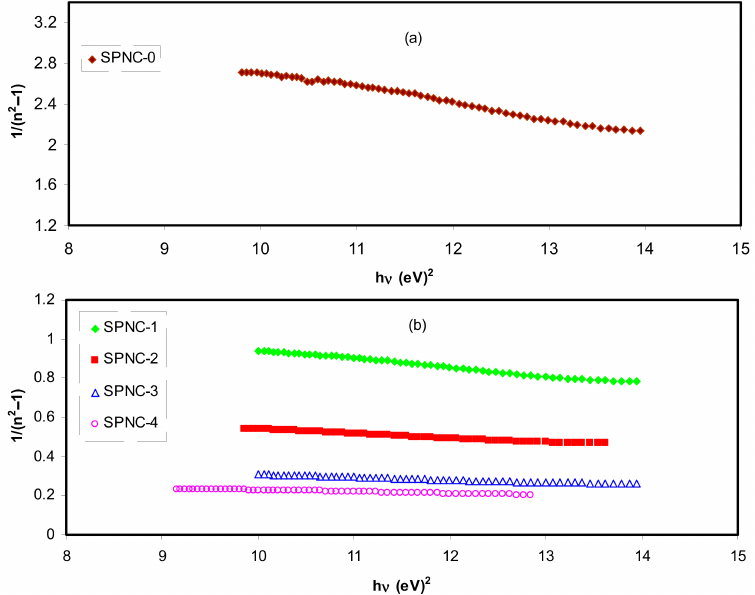
Figure 13. Variation of (n 2 − 1) 1/2 versus ( h υ ) for ( a ) pure PVA film and ( b ) PVA NCPs